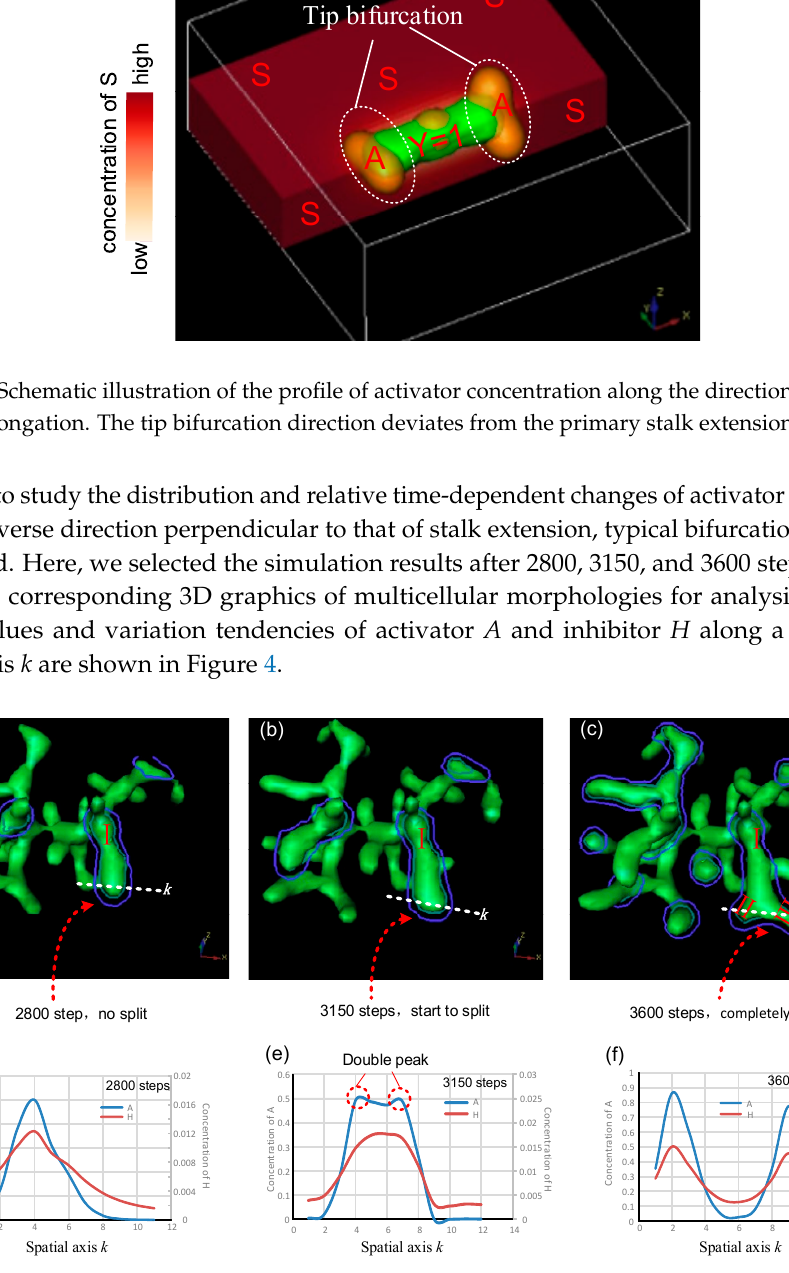
Figure 4. Simulation results for branching behaviors in typical tip bifurcation. ( a – c ) Spatial distributions of the cellular differentiation marker Y after 2800, 3150, and 3600 steps, respectively. Variation tendencies of the activator and inhibitor along the spatial axis k after 2800, 3150, and 3600 steps, respectively ( d – f ). The tip bifurcation could be examined along the spatial axis k on the plane defined by the blue, closed contours. The coordinates on the horizontal and vertical axes are dimensionless. Parameters: c = 0.04, μ = 0.8, v = 0.08, ρ A = 0.03, ρ H = 0.0001, c 0 = 0.02, γ = 0.02, ε = 0.042, d = 0.008, e = 0.1, f = 10, D A = 0.1, D H = 0.26, D S = 0.06.